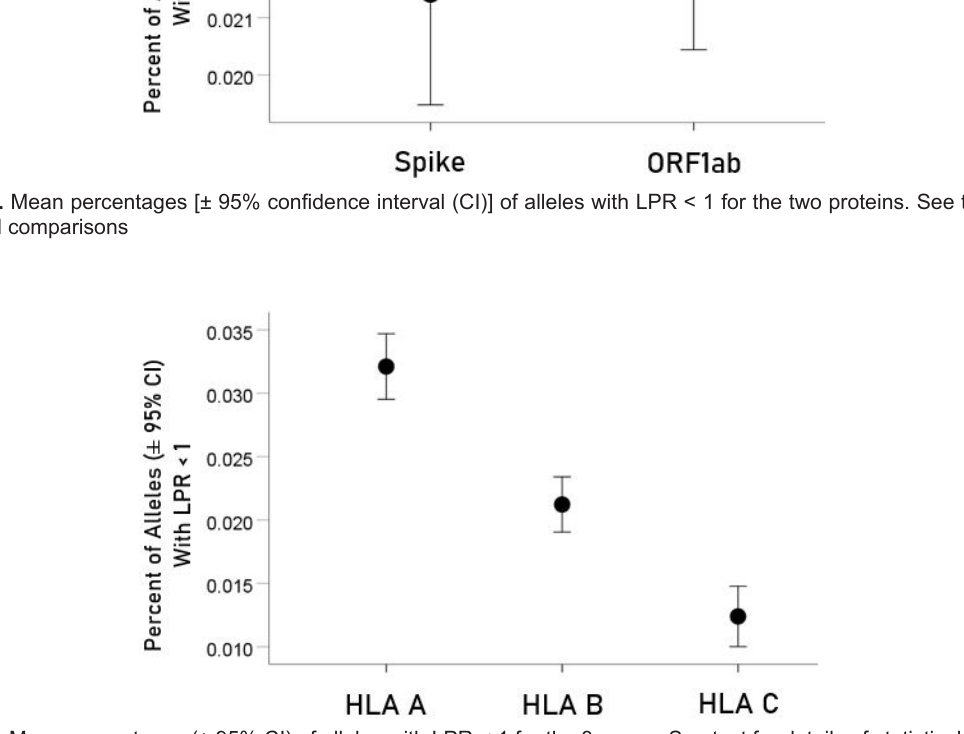
Figure 3. Mean percentages (± 95% CI) of alleles with LPR < 1 for the 3 genes. See text for details of statistical comparisons